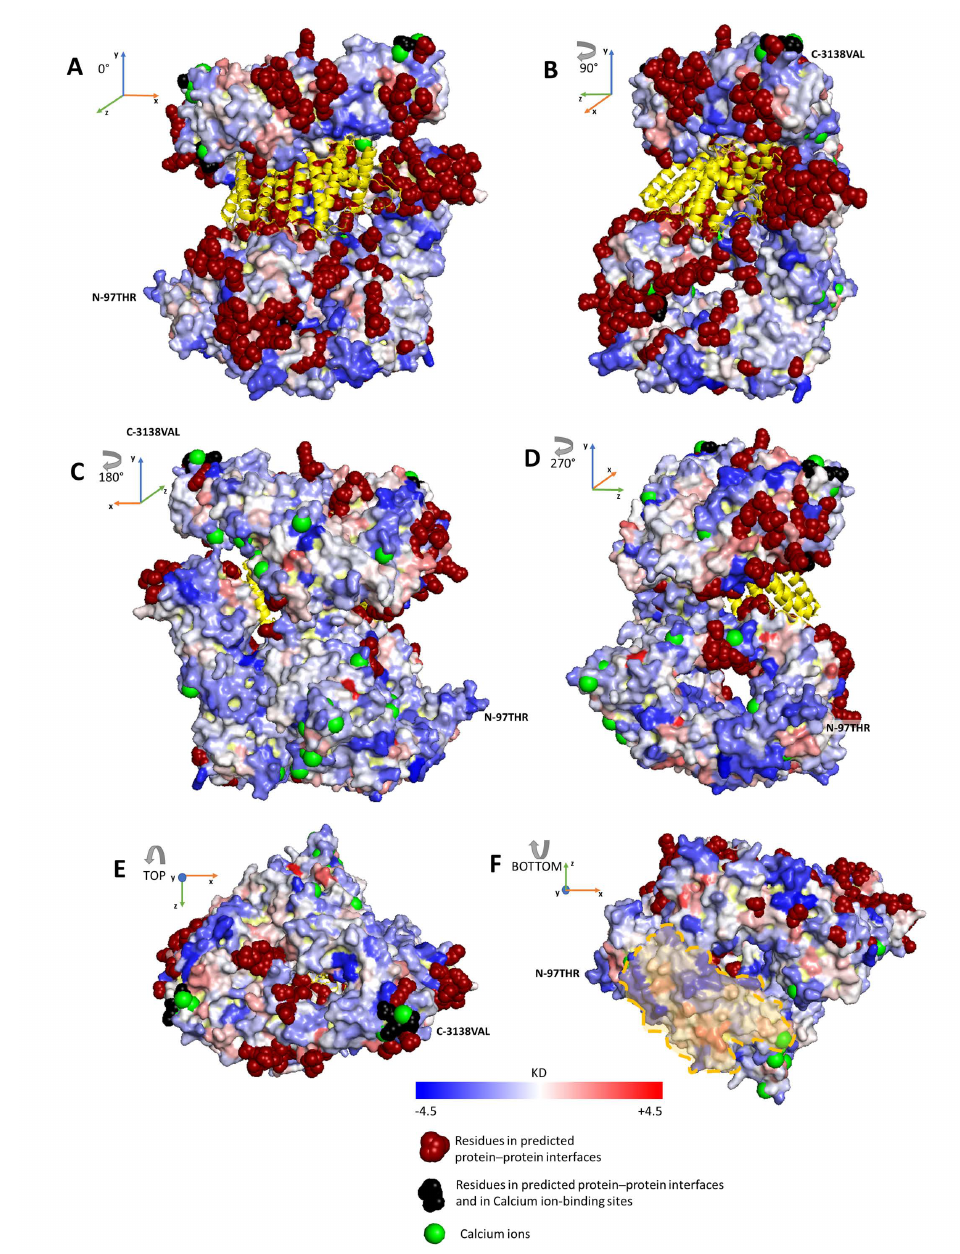
Figure 5. The computed calcium-binding sites of the huntingtin protein surface. The Figure depicts the protein structure of huntingtin in complex with HTT -associated protein 40 (HAP40 , colored in yellow) [19] and captured by six different views: with a clockwise rotation of the protein around the vertical axis with 90-degree steps ( A – D ) and the top and bottom views with respect to the vertical axis ( E , F ). Calcium ions are showed as green spheres with a 2.0 Å radius and computed with FEATURE [22]. Thirty-four calcium binding sites were predicted with a 95% precision. Dark-red spheres are atoms of residues predicted as interacting by ISPRED4 [21]; black spheres are atoms of interacting residues found in the 3.5 Å-radius neighborhood of the calcium ions (Table S1). We highlighted a light orange region, 166–443, described as a possible membrane-binding region